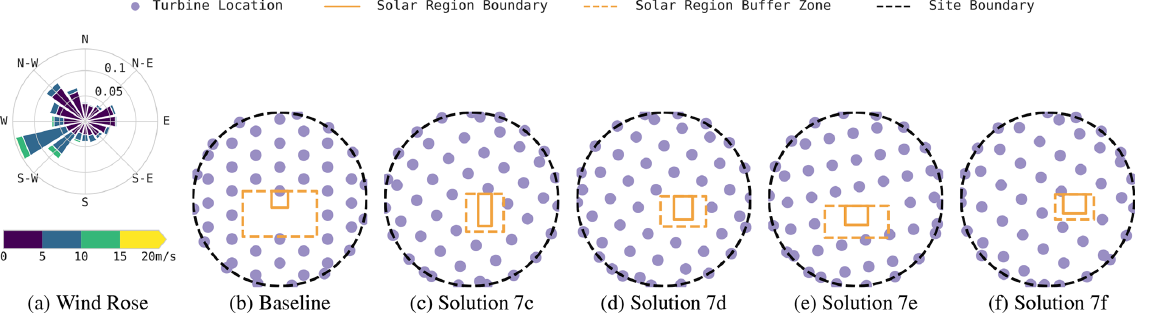
Figure 8. CMA-ES solutions for the low-correlation location and circular